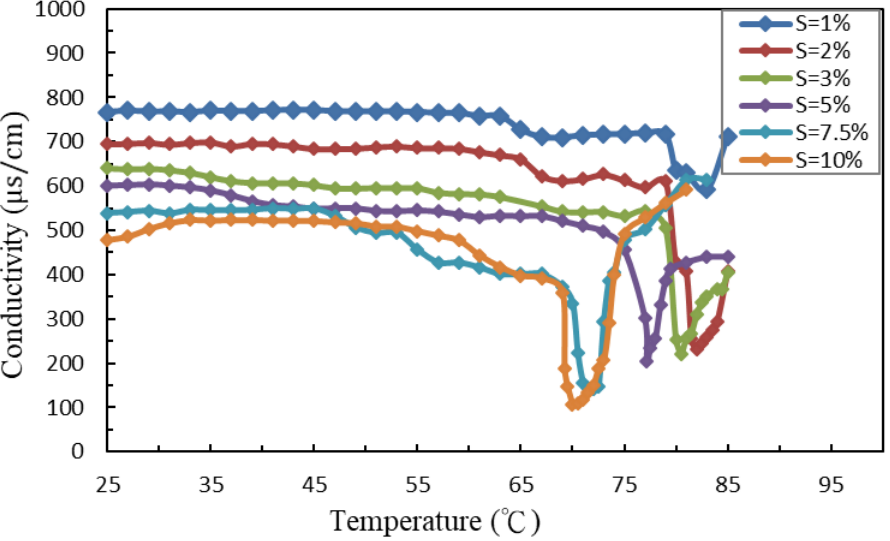
Figure 2. Effects of heating temperature and surfactant Span 80/Tween 20 concentrations on the electrical conductance of emulsions.